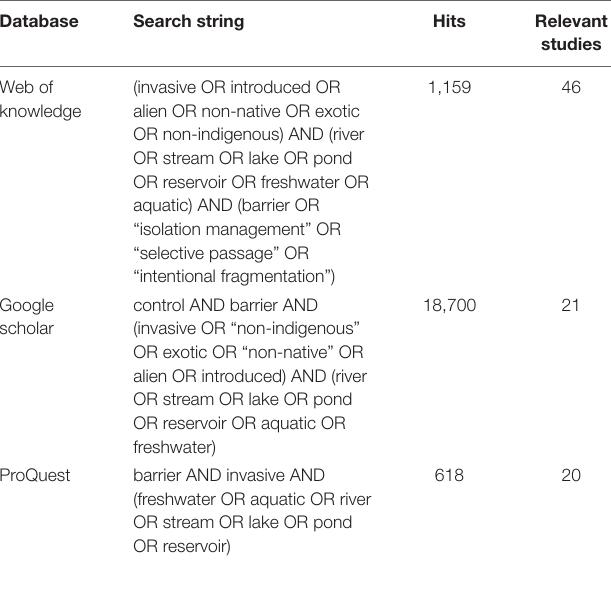
TABLE 1 | Search string used to find relevant literature in databases, along with number of hits and the relevant studies identified according to predetermined